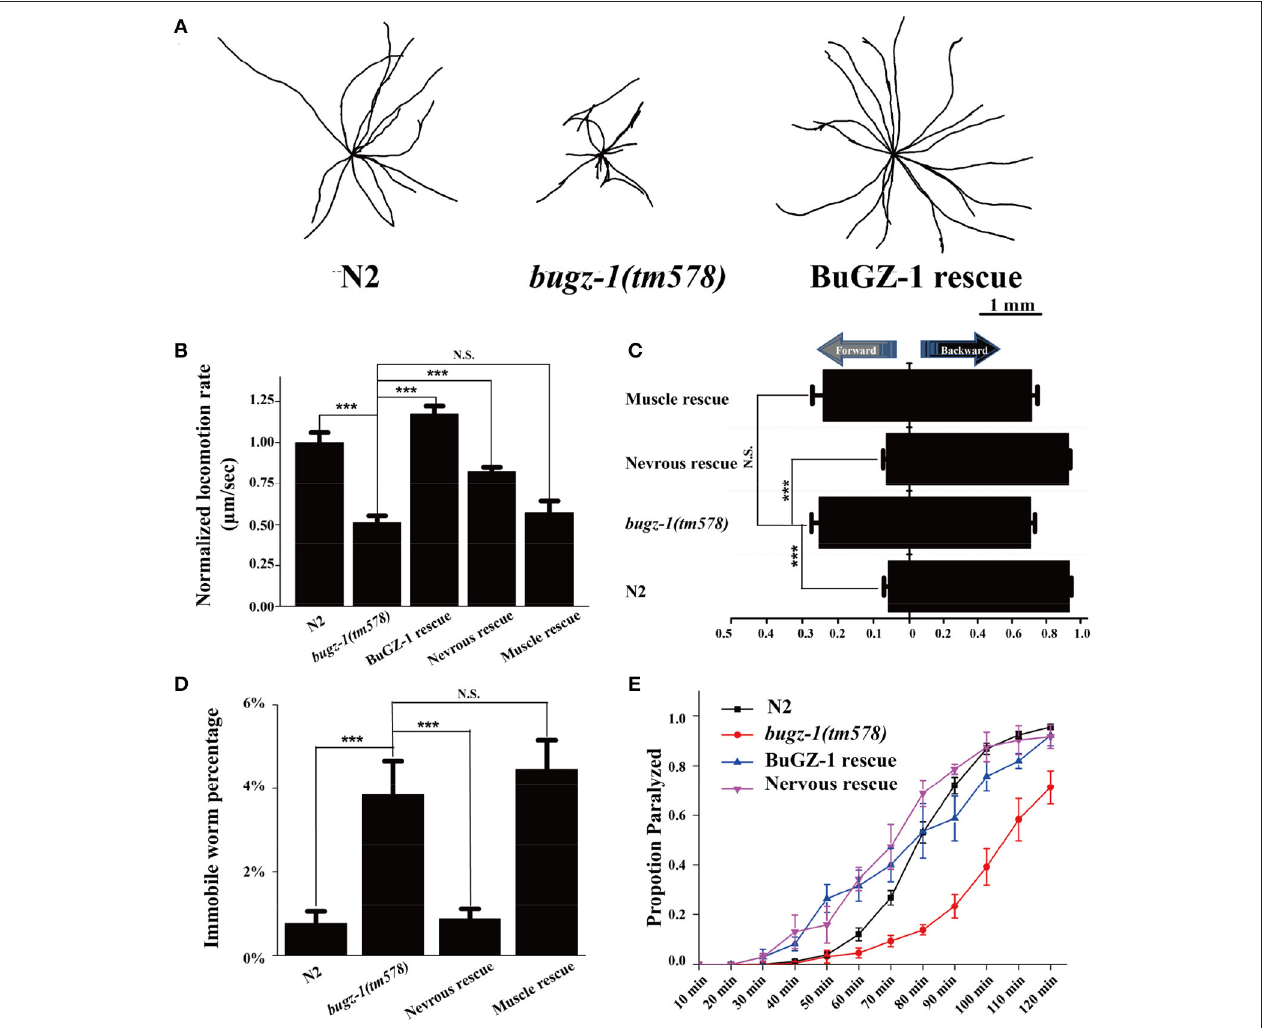
FIGURE 4 | BuGZ-1 regulates acetylcholine secretion and worm locomotion. (A,B) bugz-1(tm578) animals displayed more hesitating and uncoordinating movement with decreased trajectories (A) and locomotion speed (B) . The locomotion rate is the average velocity of each worm in 40 seconds. (C,D) bugz-1(tm578) mutant worms prefer to move backward or stay immobile. (C) Statistic comparison of average proportion of time spent on moving forward or backward for indicated worms. (D) Percentage of worms stay immobile in indicated genotypes. All the locomotion defects of bugz-1(tm578) can be rescued by endogenous expressed BuGZ-1 ( bugz-1::gfp ) and nervous expressed BuGZ-1 ( rab-3p::bugz-1::mCherry ) but not muscle expressed BuGZ-1 ( myo-3p::bugz-1::mCherry ) in mutation background. The number of worms analyzed for locomotion is n = 15 for each genotype. (E) Proportion paralyzed over time from indicated worm strains exposed to 1 mM aldicarb. Aldicard resistance defect of bugz-1(tm578) was rescued by endogenous expressed BuGZ-1 and nervous expressed BuGZ-1 but not muscle expressed BuGZ-1 in mutation background. 25–35 young adult animals were tested for aldicarb resistant experiment, at least three independent experiments were performed. Values that significantly differ from controls are indicated (*** p < 0.001 by two-tails Student’s t -test). N.S. indicates no significant difference from worm genotypes compared. Error bars represent